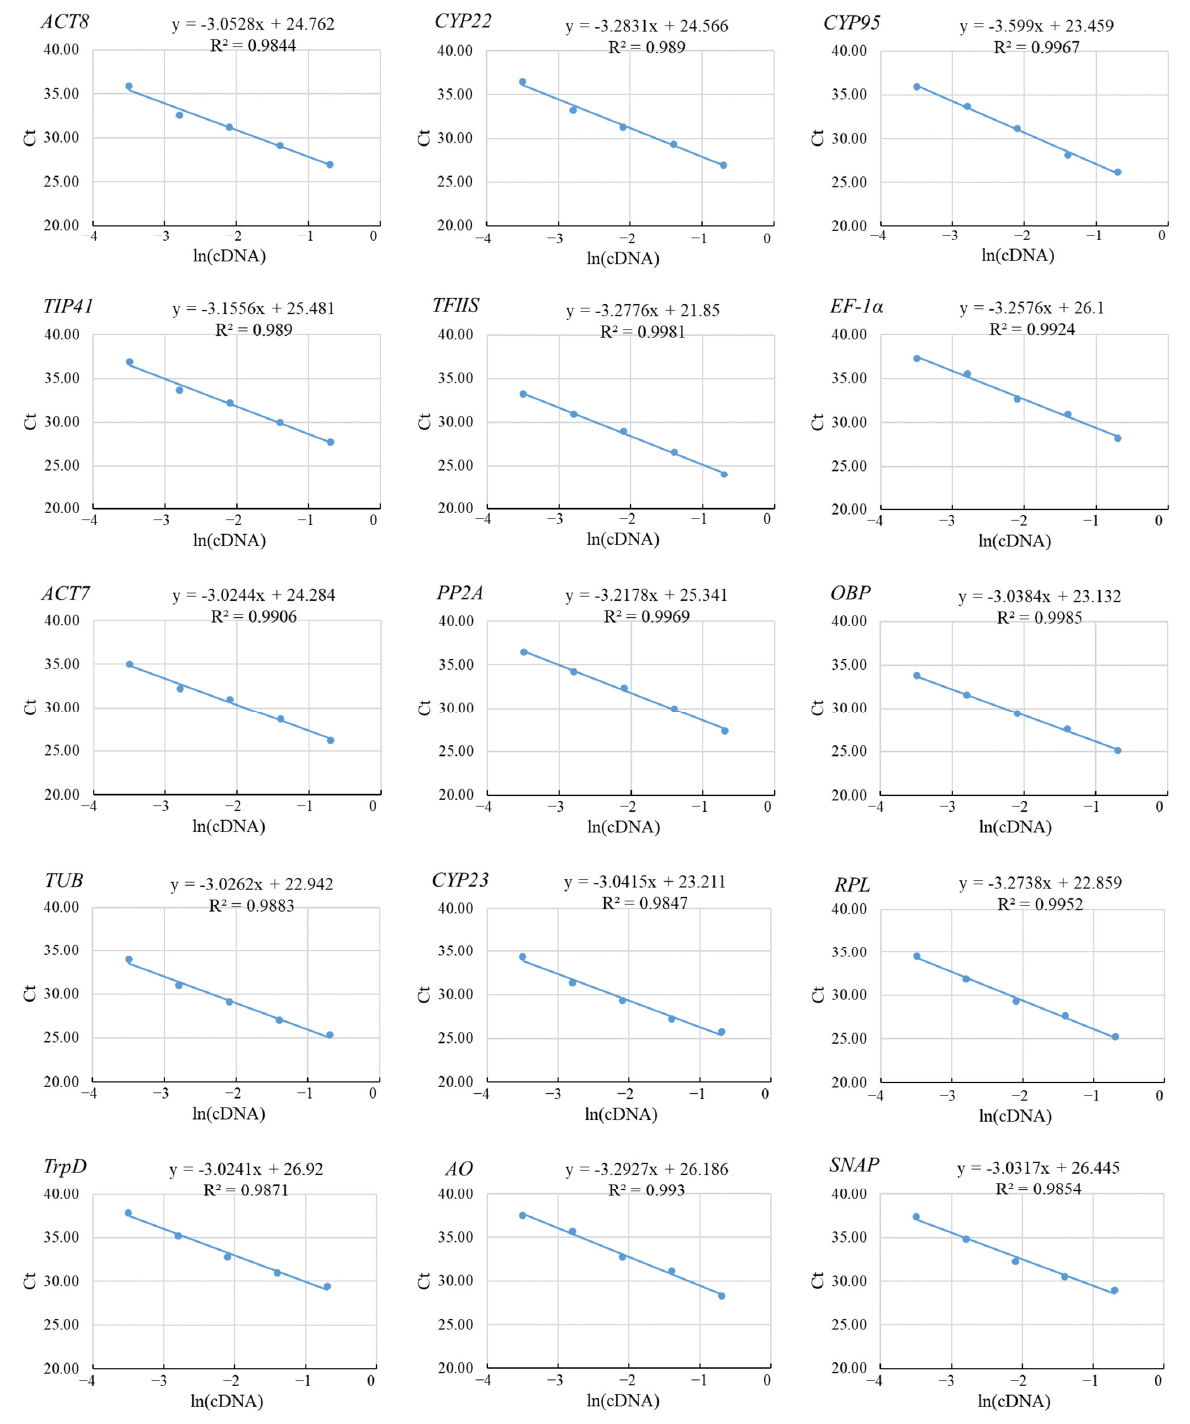
Figure 2. The correlation coefficient of each primer pair used for RT-qPCR. A graph of Ct value vs. the serial dilution factor of cDNA was drawn to determine the correlation coefficient (R 2 ). Its value for each reference gene has been mentioned within the respective